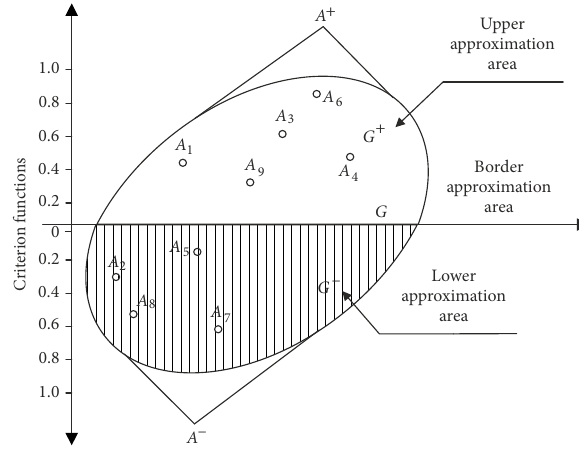
Figure 2. Upper G + , lower G – and border G approximation